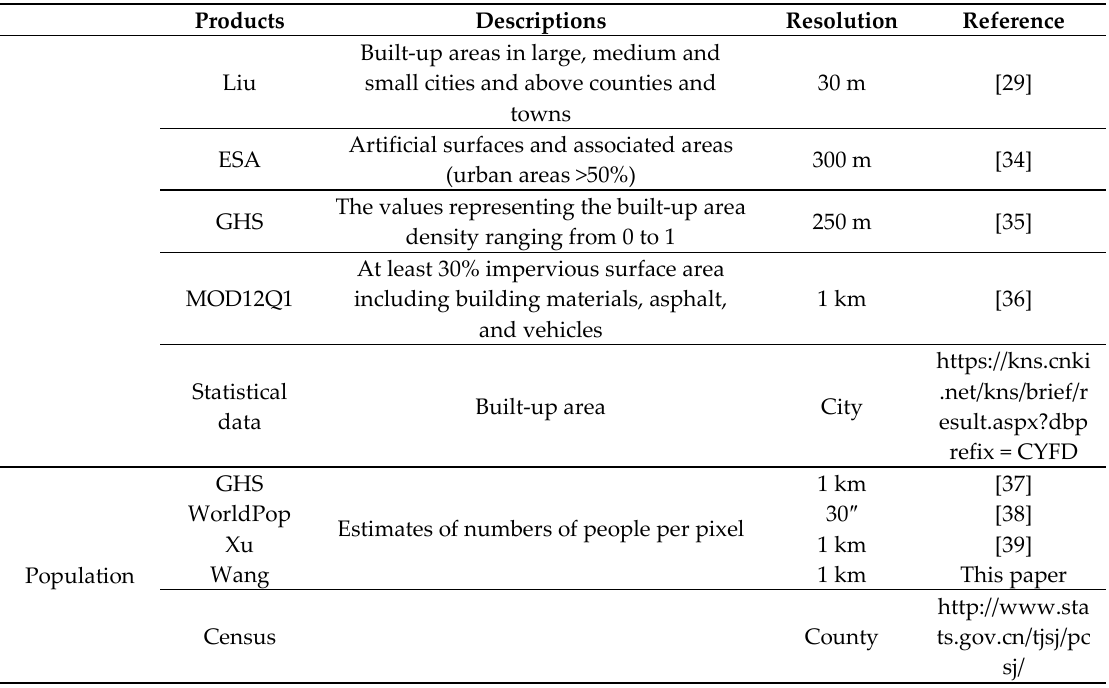
Table 5. The data descriptions of other